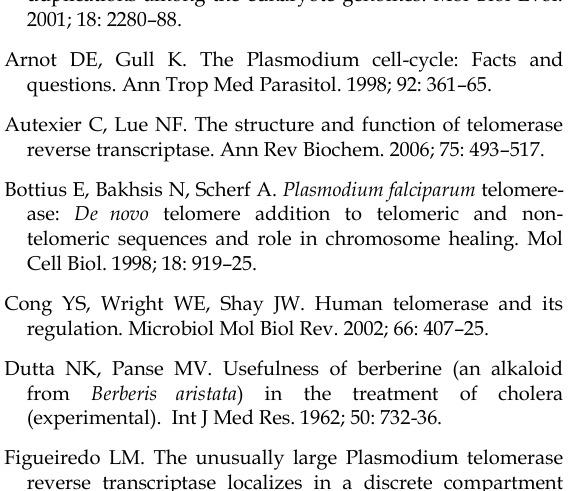
Figueiredo LM. The unusually large Plasmodium telomerase reverse transcriptase localizes in a discrete compartment